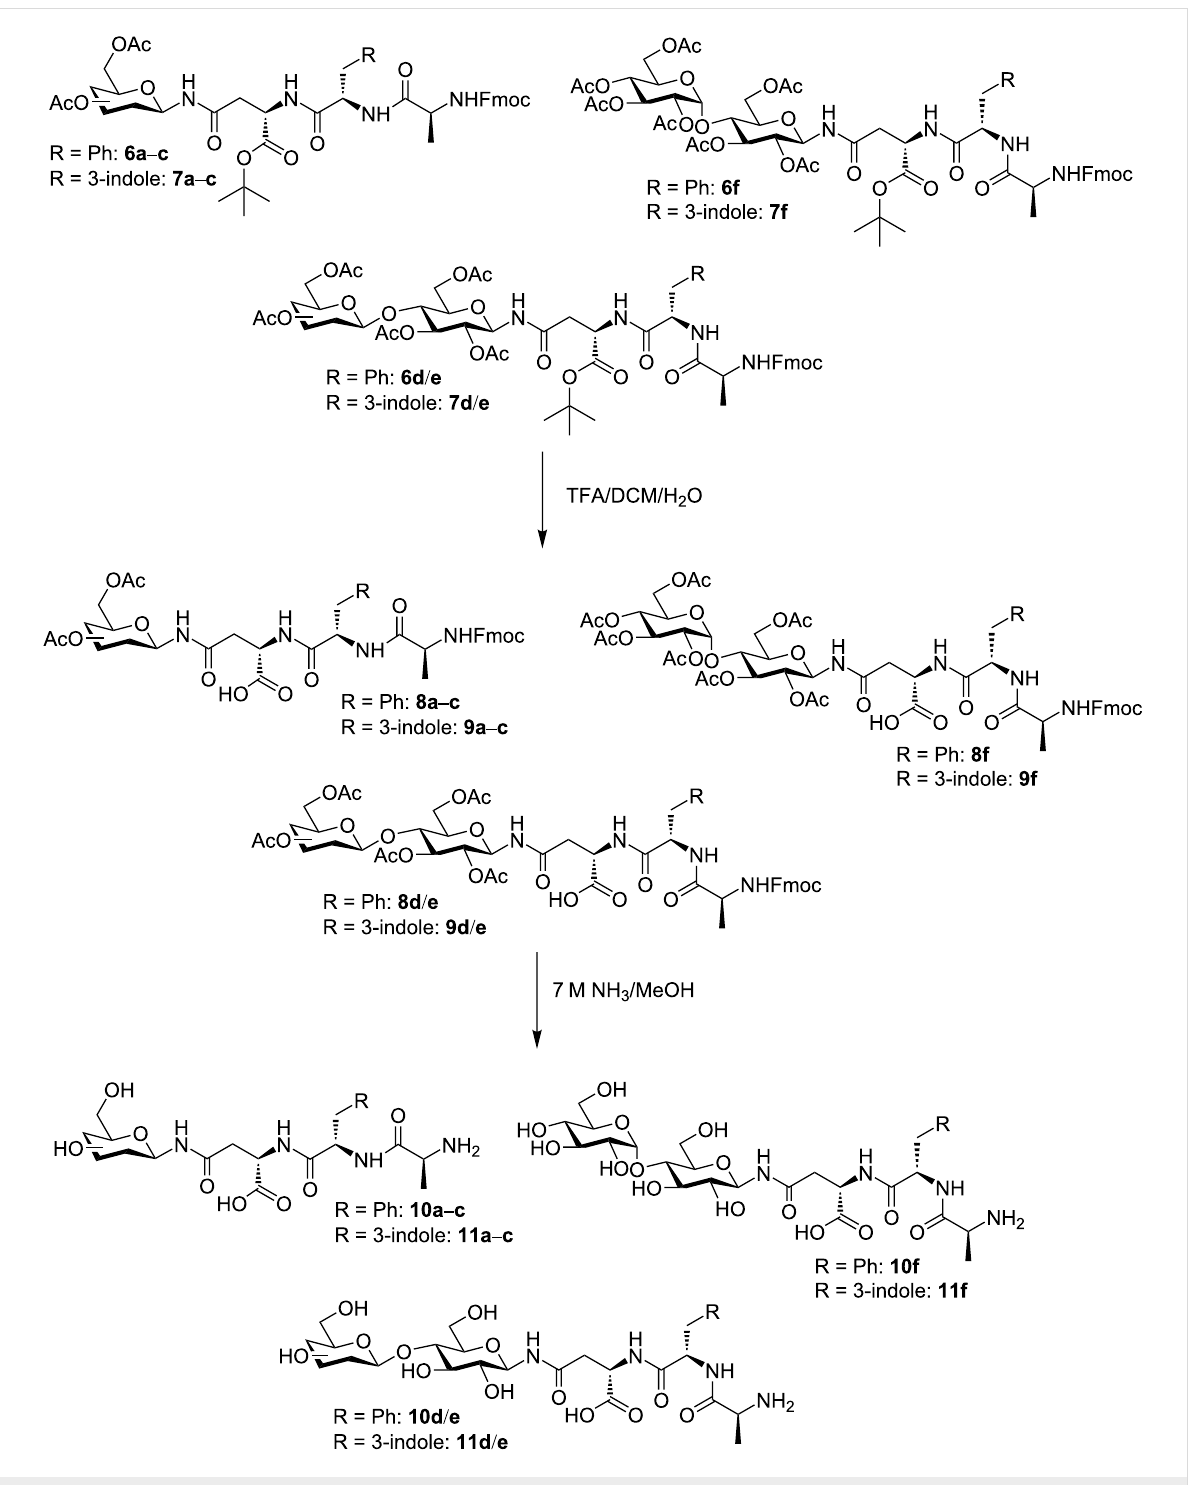
Scheme 3: Cleavage of the fully protected peptides 6 and 7 .